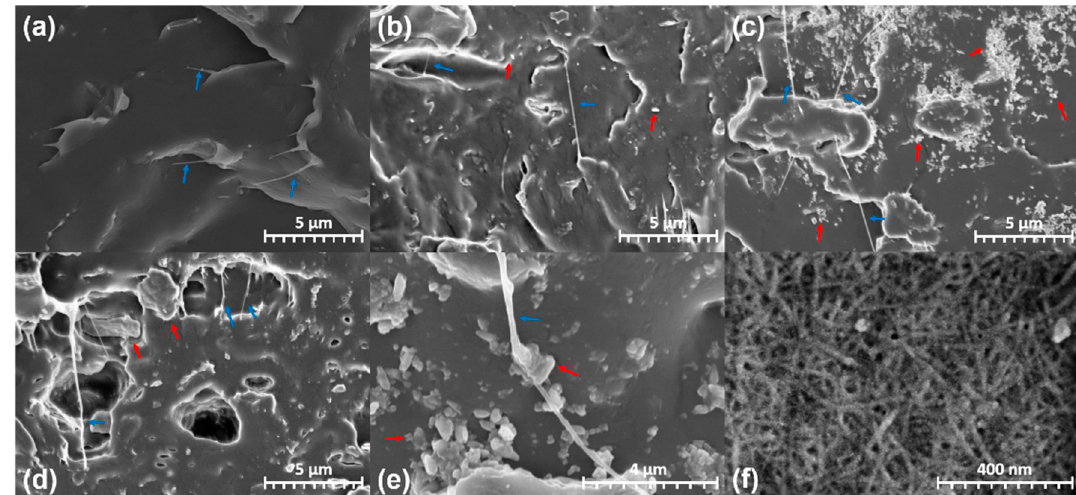
Figure 3. C1s, O1s, and N1s regions of XPS spectra of ( a ) PP and ( b ) plasma-treated PP.